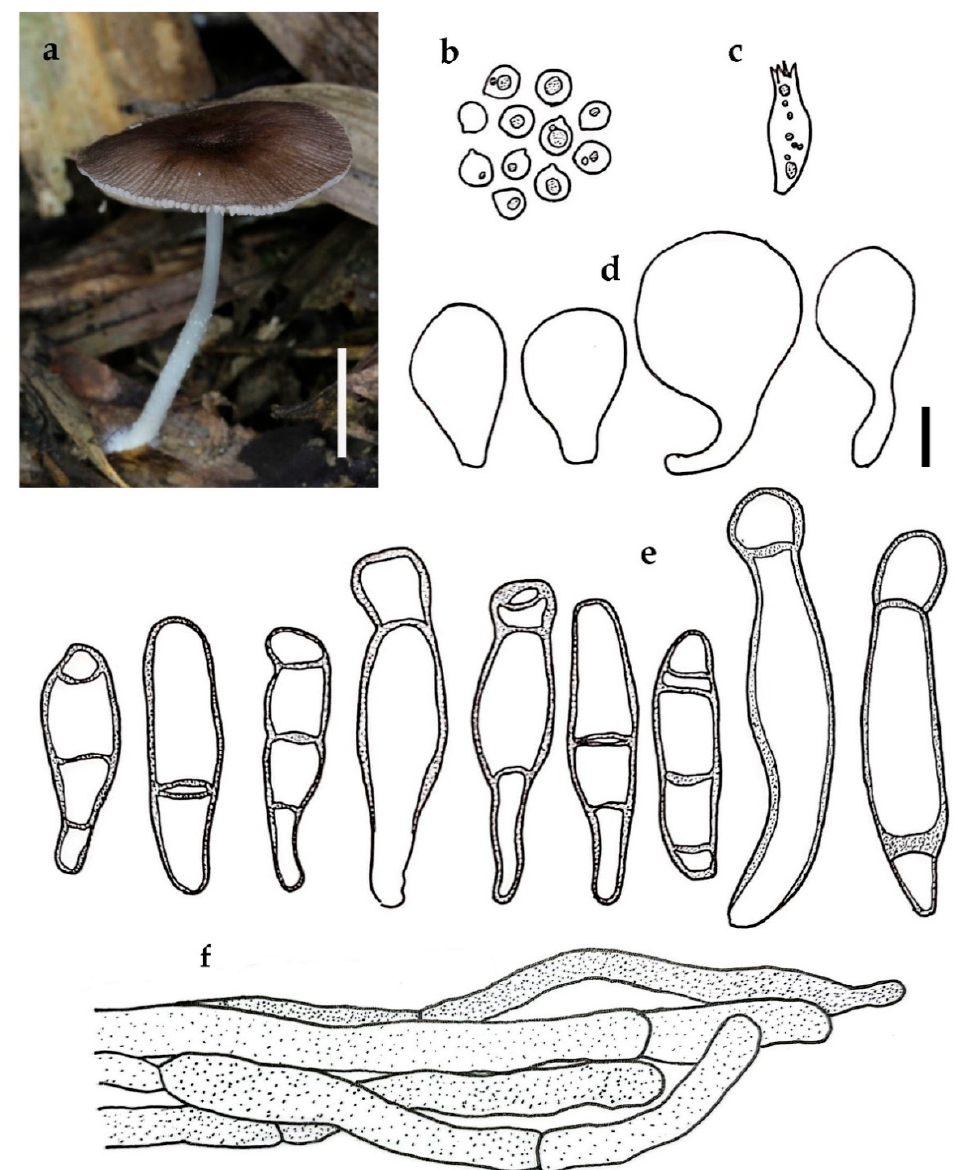
Figure 7. Pluteus setocystidiatus BKF 10212: ( a ) habit; ( b ) basidiospores; ( c ) basidium; ( d ) cheilocys- tidia; ( e ) pleurocystidia; ( f ) pileipellis element. Scale bars: ( a ) = 10 mm; ( b – f ) = 10 μ